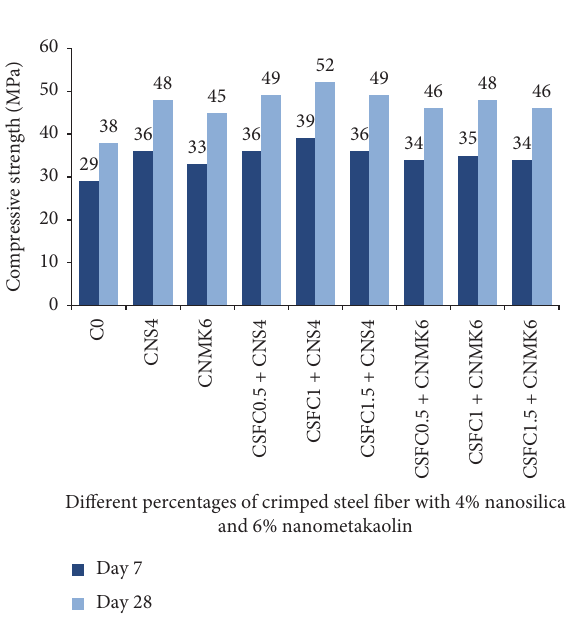
Figure 6: Using different % of hooked-end steel fiber with 4% NS and 6% NMK on compressive strength.